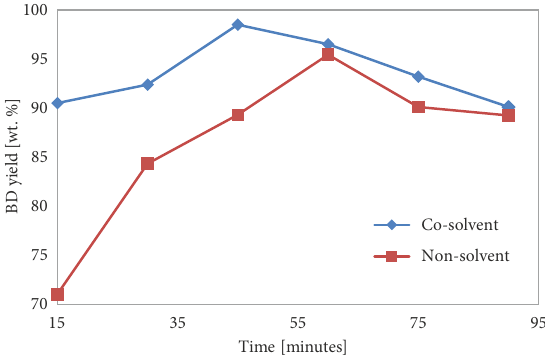
Figure 5. Influence of reaction time on BAO conversion Figure 6. Influence of co-solvent type on BAO